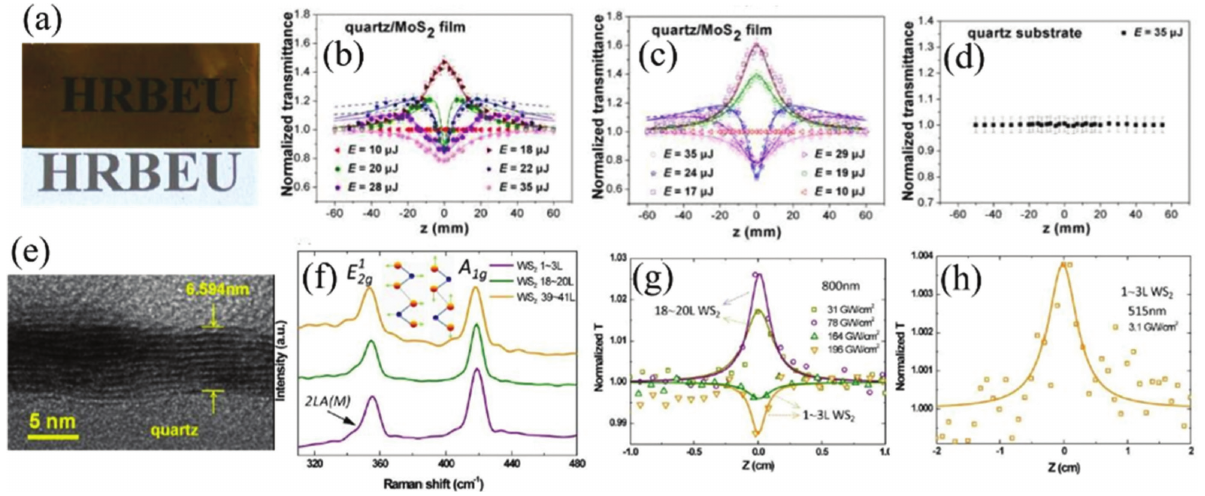
and WS . 2 2 film and quartz glass substrate. (B) and (C) The OA Z-scan curves of the quartz/MoS 2 film. (F) Raman spectra of the WS . (G) Z-scan results at 800 nm (40 fs). (H) Z-scan results at 2 2